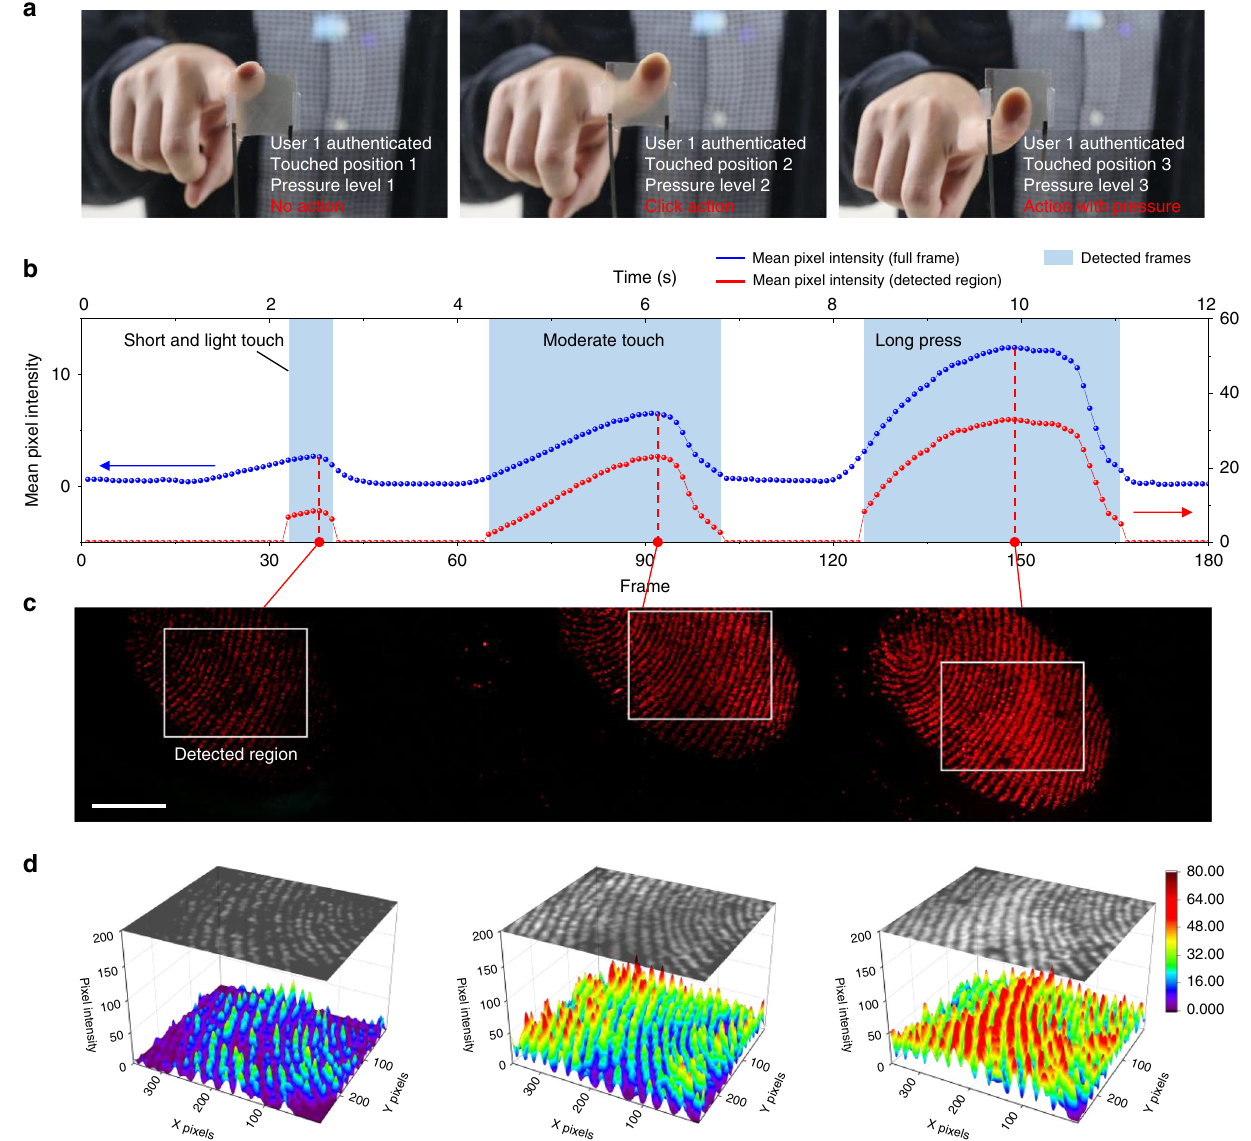
Fig. 6 Application to real-time smart touch interfaces. a Conceptual illustration of smart touch interfaces that can identify the user and exact location of touch using the photonic skin. b Mean pixel intensities (MPIs) of the images captured by a charge-coupled device (CCD) at 15 fps where the device was touched with a fi nger three times with different positions, forces and durations (blue dots: MPIs of full-size images, red dots: MPIs of the regions detected as a fi ngerprint of the user). c Three frames containing the detected regions when the touch force reached the maximum value during each touch. White rectangles denote the regions detected as a fi ngerprint of the user. Scale bar, 5 mm. d Pixel intensity maps for the Gaussian- fi ltered images ( σ = 3) of the detected regions in c